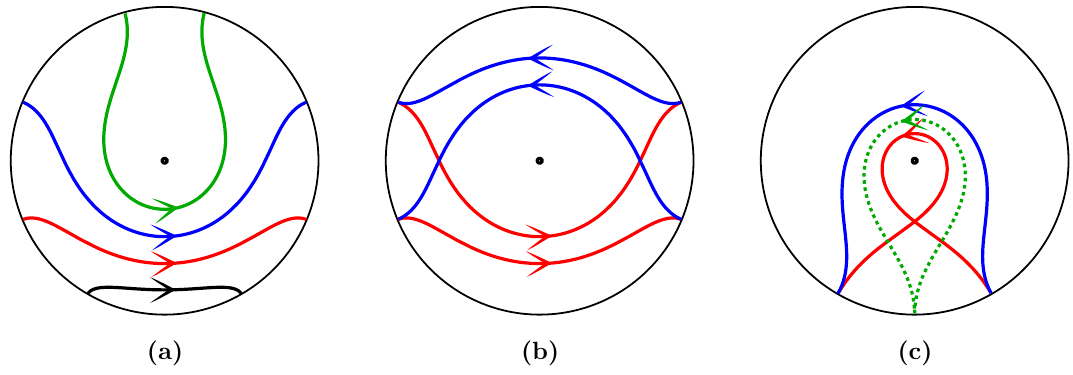
Figure 8 . (a) Oriented geodesics away from the defect are continuous in length and shape as their opening angle is increased. (b) Geodesics with the same endpoints but di(cid:11)erent orientation cannot be smoothly transformed into one another across the defect. (c) As the opening angle of the blue geodesic increases it reaches the dashed geodesic. The red geodesic also reaches the dashed geodesic as its opening angle decreases, showing continuous behaviour even as the winding number